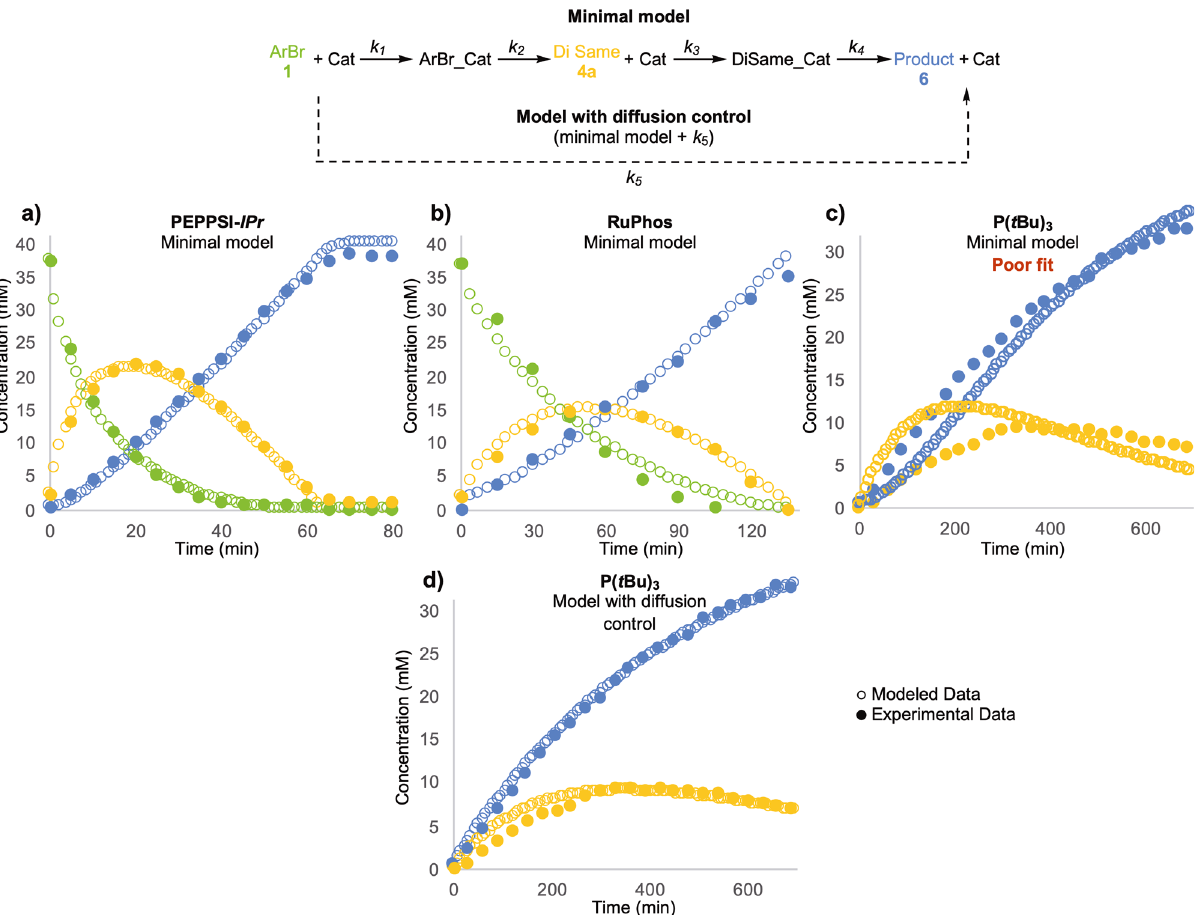
Fig. 5 COPASI model of monodentate ligands. a The COPASI modeled data without diffusion-controlled coupling overlaid with the acquired experimental data for PEPPSI-IPr. b The COPASI modeled data without diffusion-controlled coupling overlaid with the acquired experimental data for RuPhos Pd G4. c The COPASI modeled data without diffusion-controlled coupling overlaid with the acquired experimental data for Pd(OAc) 2 /P( t Bu) 3 . d The COPASI modeled data with diffusion-controlled coupling overlaid with the acquired experimental data for Pd(OAc) 2 /P( t Bu) 3